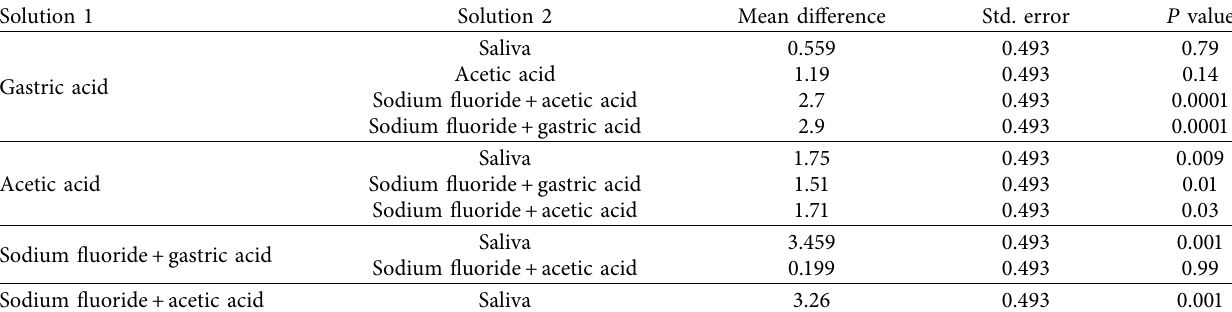
Table 5: Pairwise comparisons of changes in Rz parameter of Vitablocs Mark II after